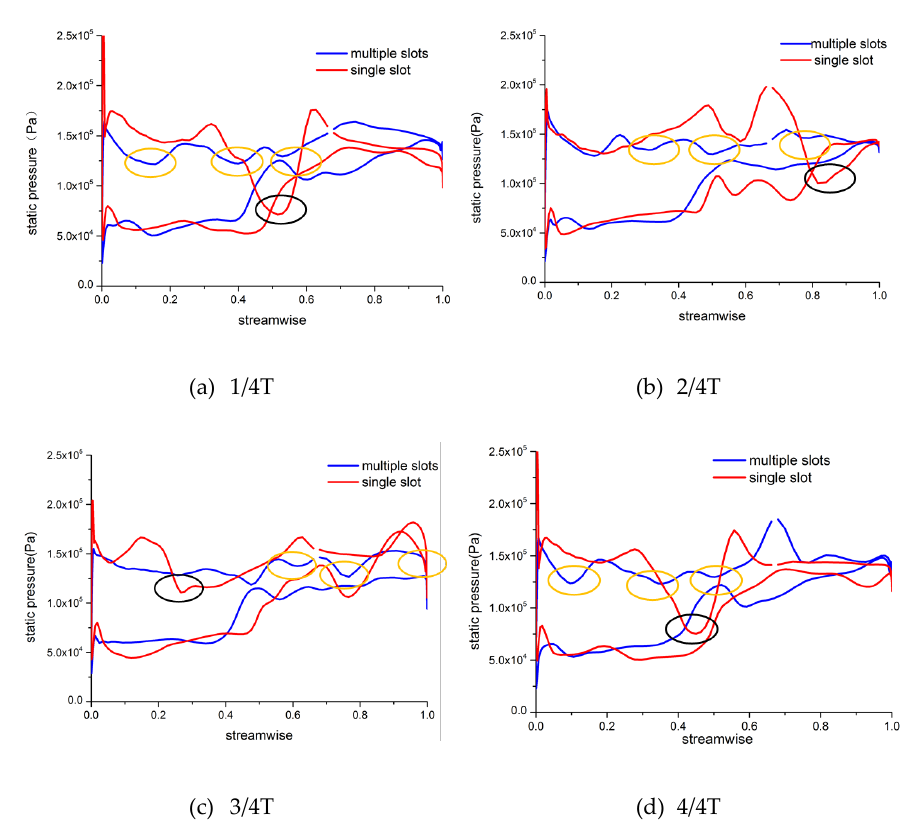
Figure 20. The tip load curves at 99% span for the casing treatment case of 3 slots per passage.